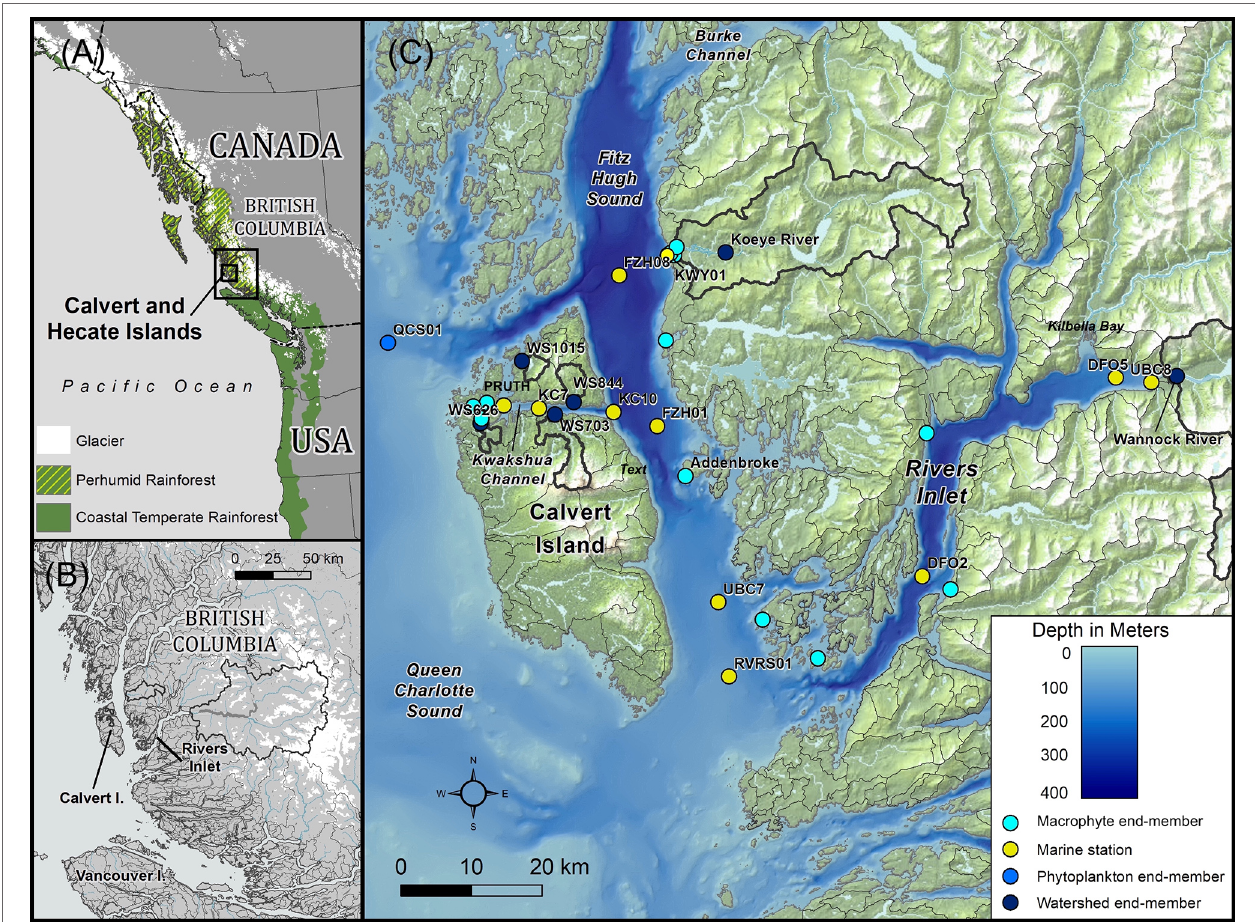
FIGURE 1 | Map of the study area along the Central Coast of British Columbia, Canada. (A) Study area within the Northeast Pacific Coastal Temperate Rainforest region, showing the extent of glaciers along the coast. (B) Inset of the study area showing the entirety of the watersheds draining into Rivers Inlet. (C) Sampling locations within the study area. Watersheds greater than 2.5 km 2 are delineated in grey, with sampled watersheds indicated by thick black